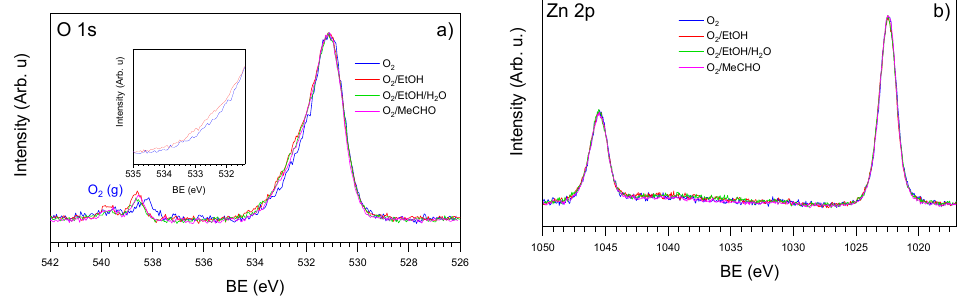
Figure 6. NAP-XPS spectra of O 1s ( a ) and Zn 2p ( b ) acquired from the ZnO NRs-based sensor in the presence of O 2 , O 2 / EtOH, O 2 / EtOH / H 2 O and O 2 / MeCHO at 327 °C.